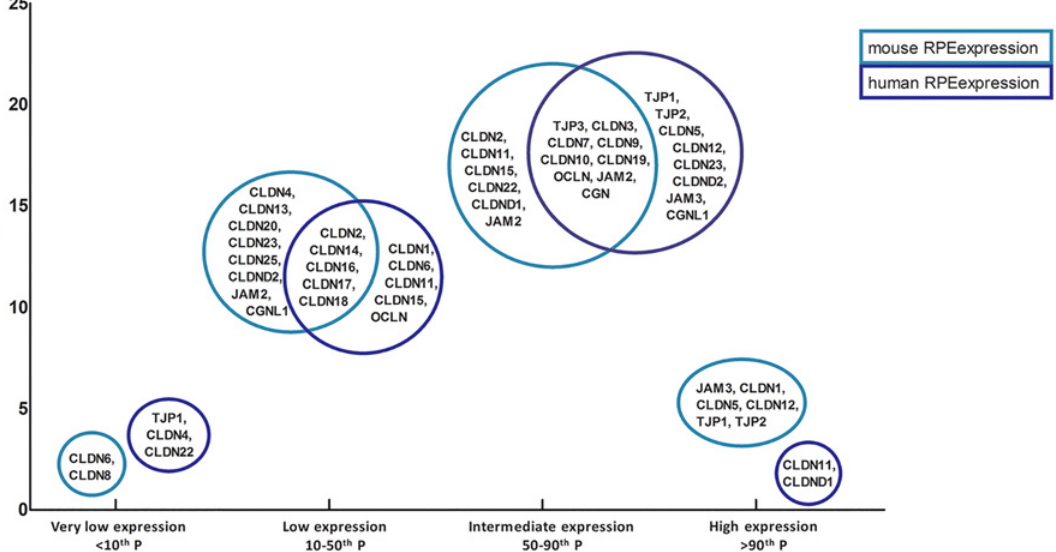
Fig 6. This diagram depicts the tight junction gene expression of mouse and human RPE, divided in four categories: high expression ( > 90 th percentile), moderate (50-90 th percentile), low (10-50 th percentile) and very low ( < 10 th percentile). On the x-axis the four categories are displayed and on the y-axis the amount of genes found in a category is depicted. Light blue circles contain genes expressed in mouse RPE, Dark blue circles genes expressed in human RPE. Genes inside the overlapping parts of the circles are expressed in the RPE in both species in that category.